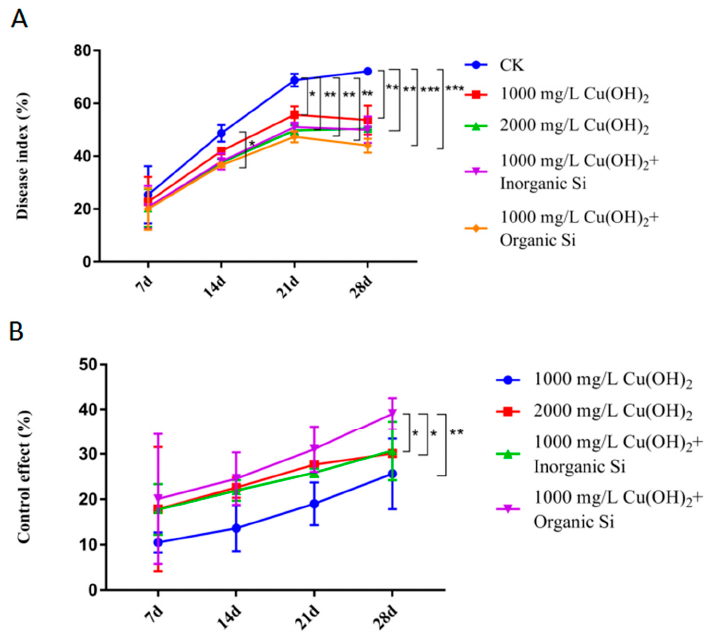
Figure 2. Disease index values ( A ) and control effects ( B ) in sugarcane with leaf scald disease at 7, 14, 21, and 28 d after inoculation with Xa . Plants were treated with one of two Cu(OH) 2 concentrations and 0.05% inorganic or organic silicon. Data are presented as the mean ± standard error ( n = 3). * indicated significance with p ≤ 0.05 (ANOVA and Tukey’s HSD), ** indicated significance with p ≤ 0.01 (ANOVA and Tukey’s HSD) and *** indicated significance with p ≤ 0.005 (ANOVA and Tukey’s HSD).